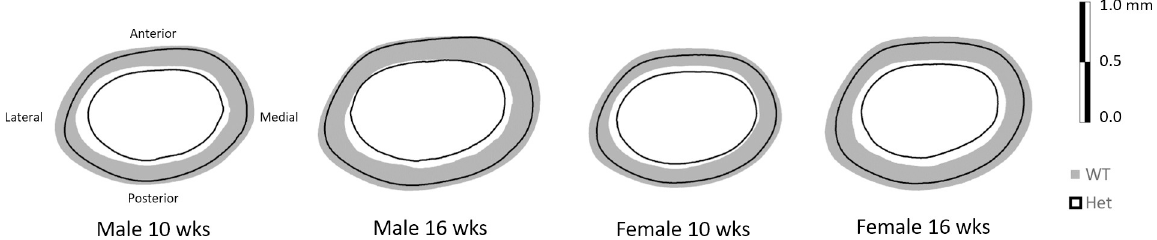
Fig 1. Schematic transverse cross sections from femoral mid-diaphysis. Shown are average profiles of the femoral cortical ROIs from all bones in each group, demonstrating that cortical bone area is consistently smaller in G610C mice in both ages and sexes.